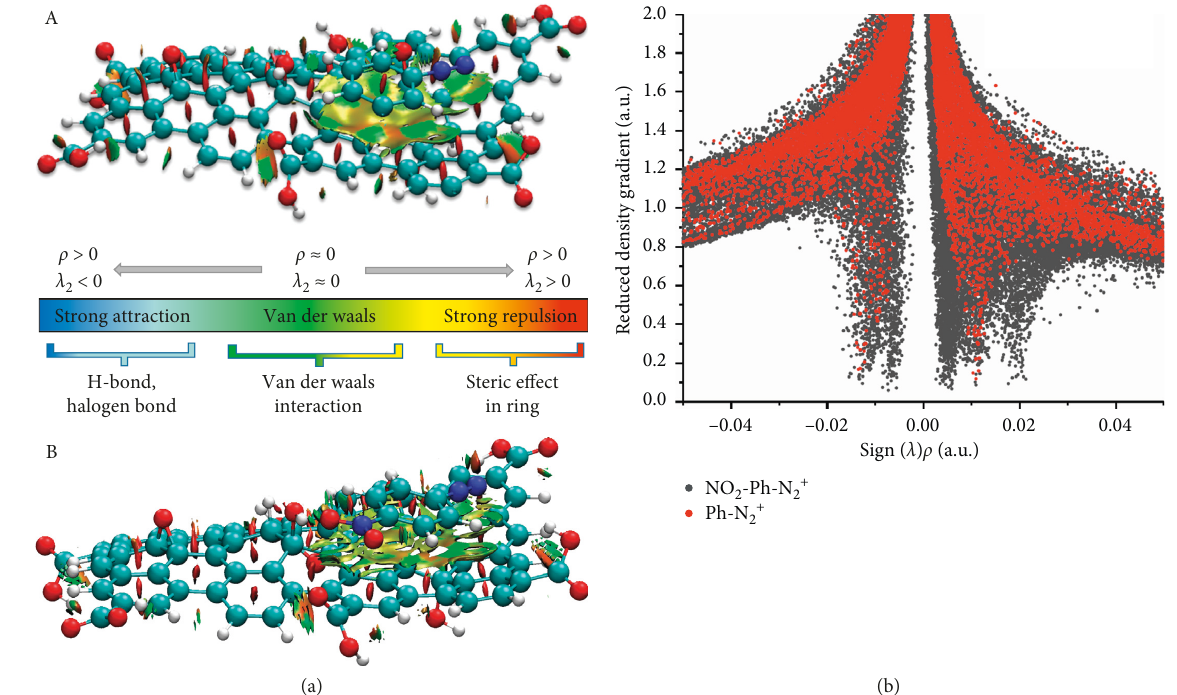
Figure 2: Noncovalent interaction surfaces (a) ((A) phenyldiazonium cation; (B) nitrophenyldiazonium cation) and (b) the plot of reduced density gradient (RDG) vs. sign( λ ) ρ for the interaction of GOx/N 2+ -Ph (red) and GOx/N 2+ -Ph-NO 2 (black).